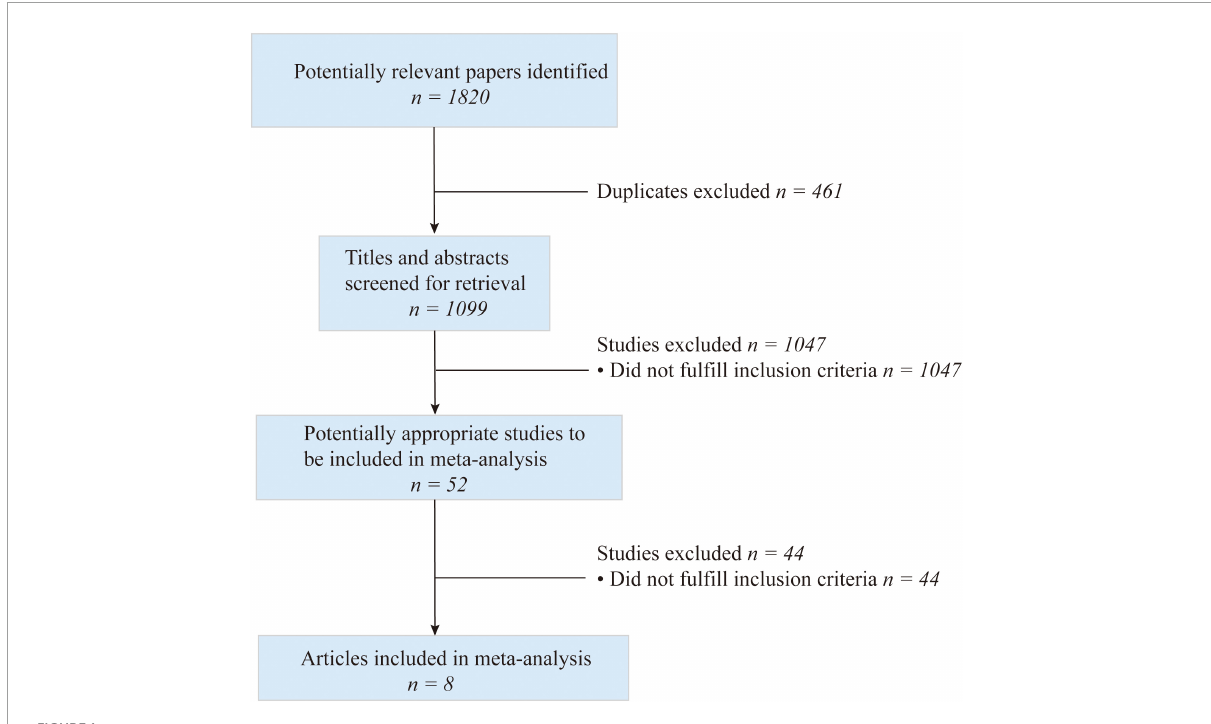
FIGURE1 Flow chart of study selection.